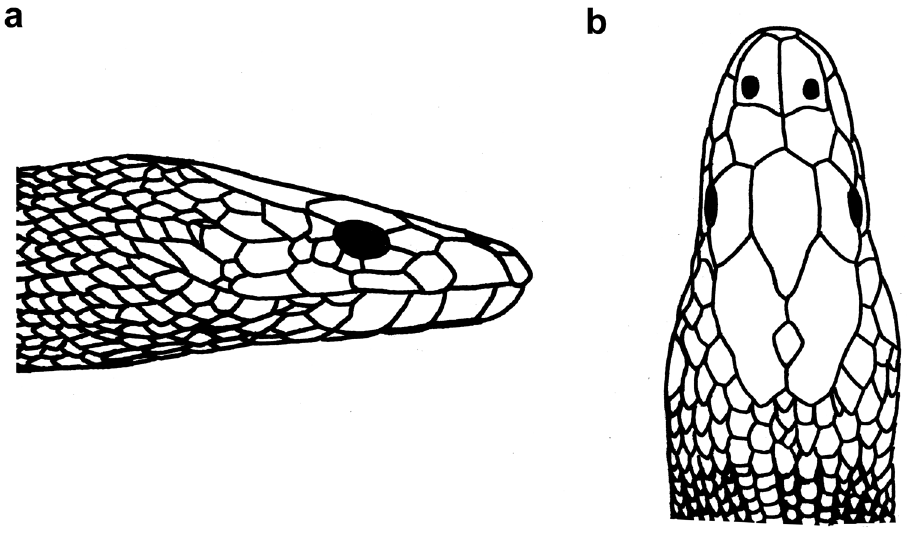
Figure 12. Head of Hydrophis platurus : a lateral view b dorsal view. 618, HL 35.8, HW 17.9, GL 29.7, SNL 5, NEL 6.8, ND 52, GBD 72, NSL 9,